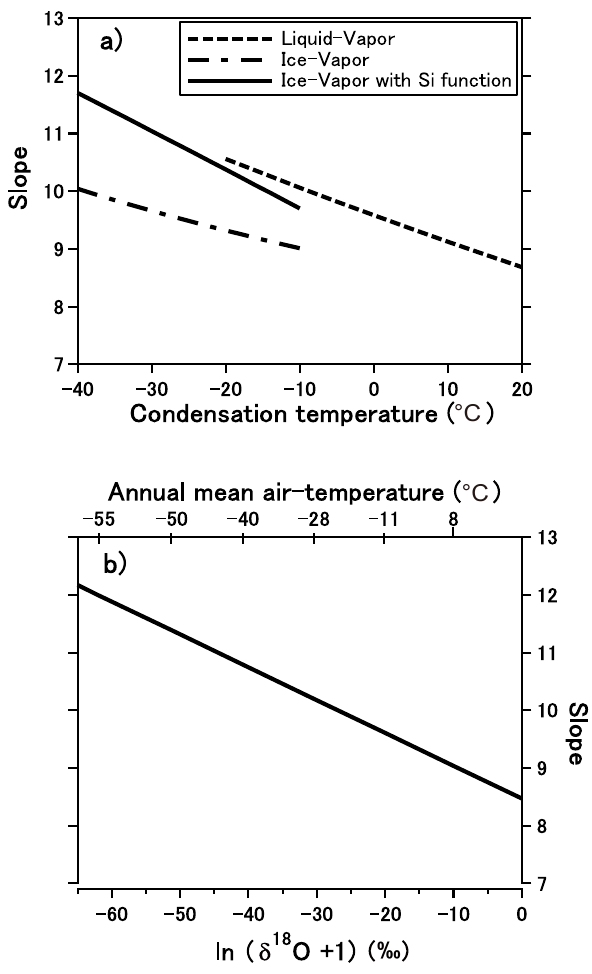
Fig. A2. Normal versus log plots for global meteoric water. The δ D/ δ 18 O slope is calculated using a differential of Eq. (7) ( =− 5.70 × 10 − 2 × ln(1 + δ 18 O) + 8.47). Kinetic fractionation dur- ing snow formation was considered using a super-saturation func- tion (see